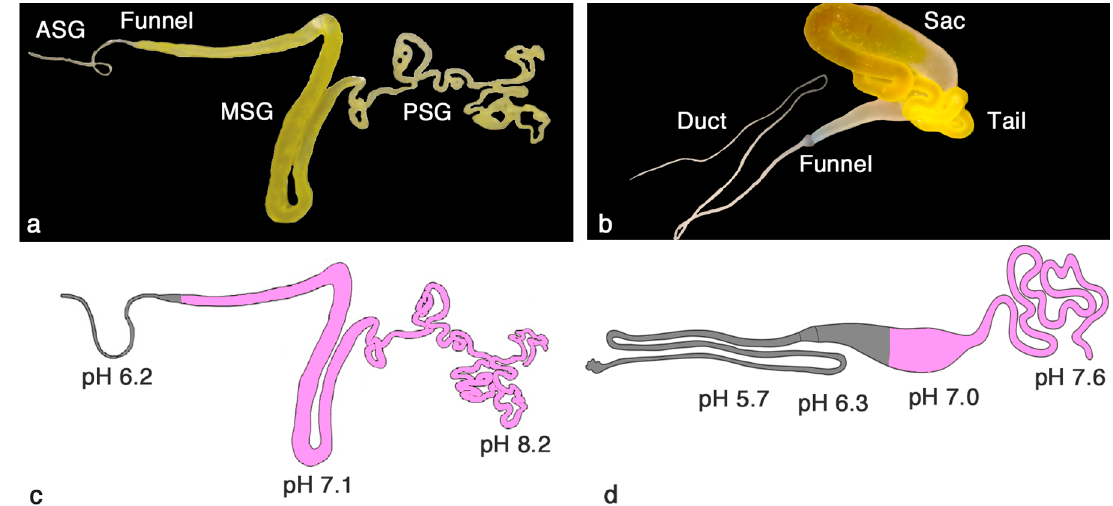
Figure 1. Macroscopic appearance of a B. mori silk gland with anterior silk gland (ASG), Funnel, middle silk gland (MSG) and posterior silk gland (PSG) identified ( a ) and a Major ampullate gland with Duct, Funnel, Sac and Tail indicated ( b ); Schematic image of a B. mori silk gland ( c ) and major ampullate gland ( d ) with pH values indicated in different parts. In (c) and (d) the regions containing epithelial cells with CA activity are shaded in grey, and fibroin/spidroin secreting parts are purple. Adapted from [8] ( a , c ) and [9,10] ( b , d ).